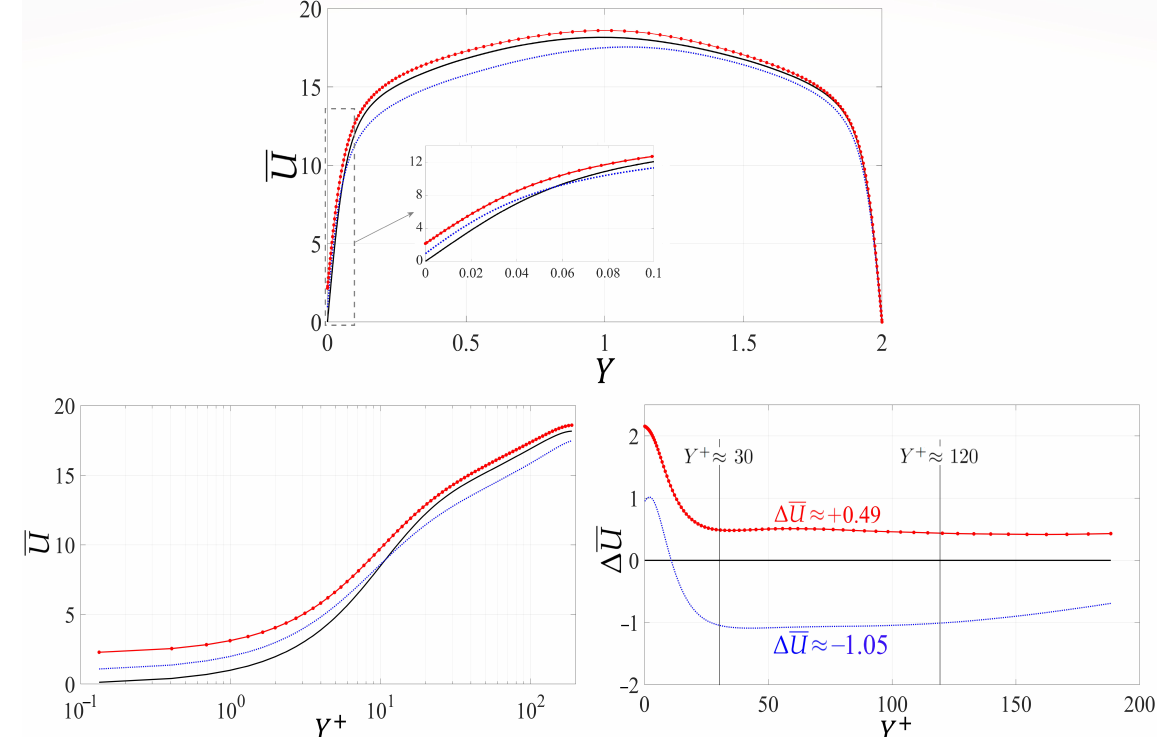
Figure 18. Mean streamwise velocity profiles plotted in global coordinates across the channel ( top ) and in wall coordinates over the permeable wall ( bottom left ), with the deviations from the smooth channel case plotted in the bottom right frame. The cases presented are: (solid black line) smooth channel; (dotted blue line) substrate TC 10 ; (red line with markers) substrate LM 10